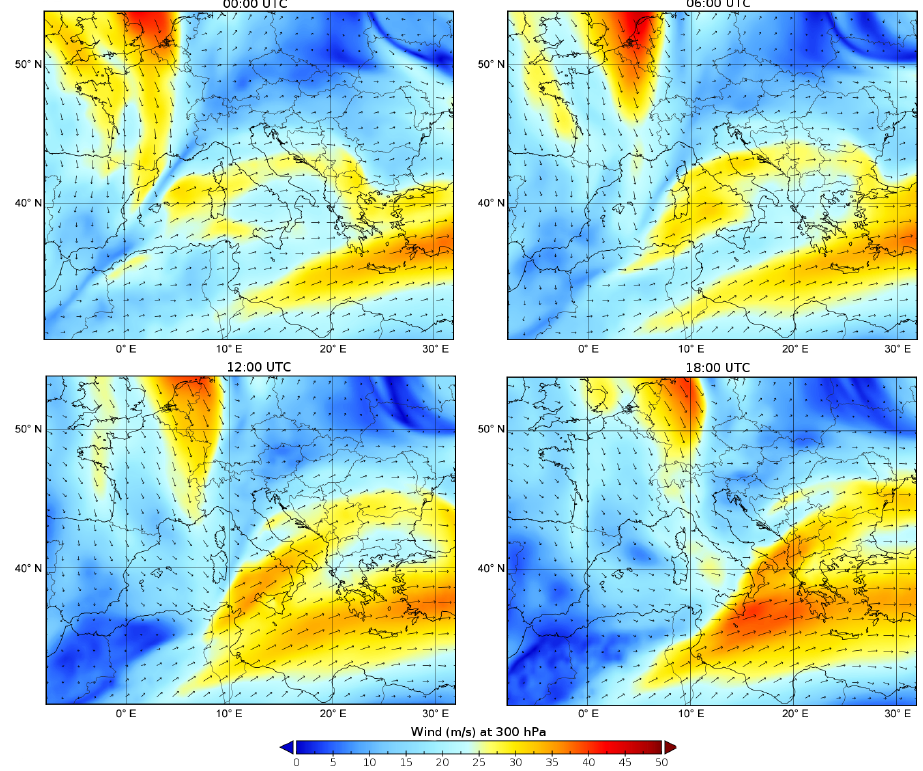
Figure 8. Wind speed [m/s] at 300 hPa at 00:00 UTC, 06:00 UTC, 12:00 UTC and 18:00